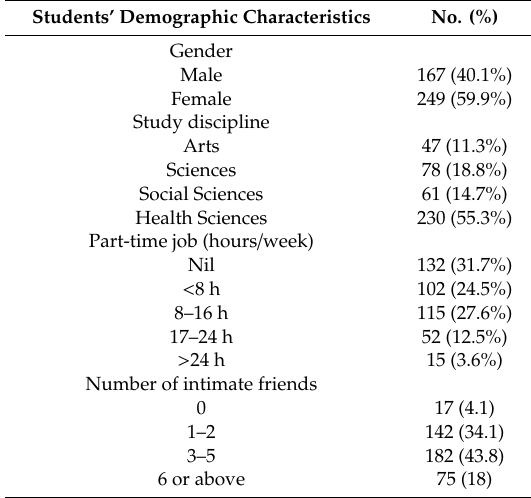
Table 1. Students’ demographic characteristics ( n =